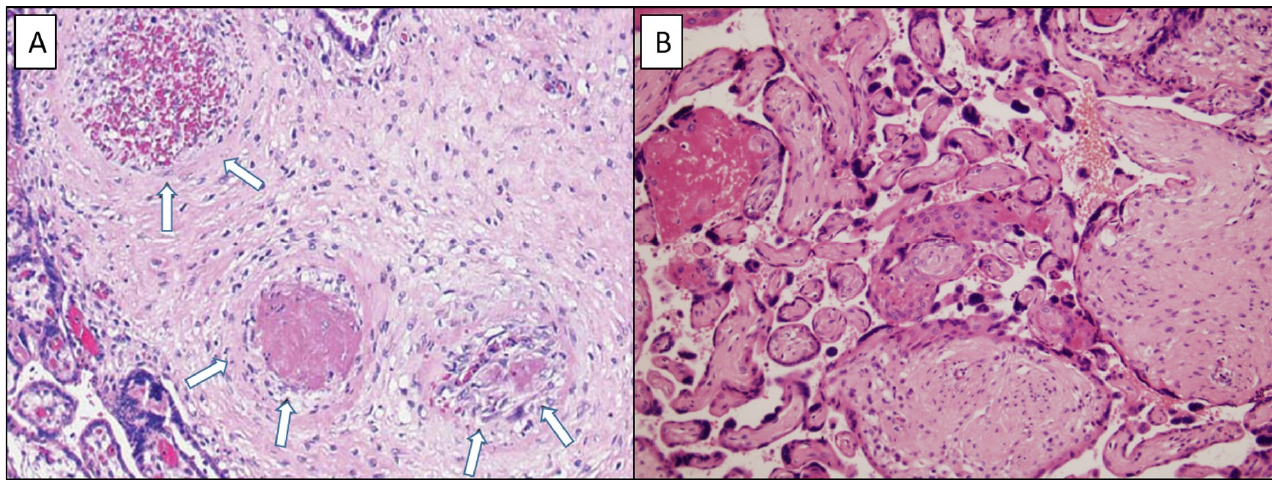
Figure 3. Maternal vascular malperfusion lesions associated with fibrinonecrotic microthrombi at different stages of formation ( A : HES ×20) within capillary vascular structures (arrows) and avascular terminal villi ( B : HES ×20).